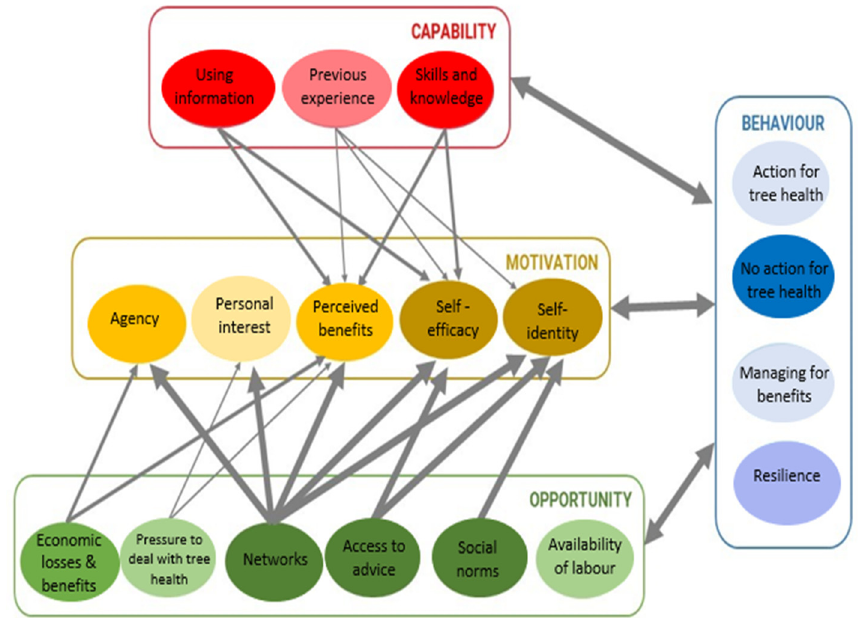
Figure 4. The strength of relationships between factors influencing farmer behaviours for tree health organized by COM-B theme and coded sub-theme. Intensity of color in circles represents the importance of sub-themes/factors. The width of linking arrows relate to the importance/strength of factors and relationships.